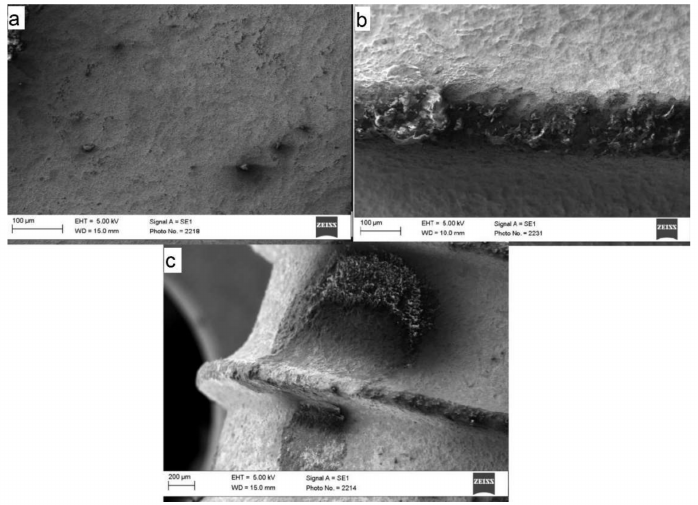
Figure 11. ( a ) The SLA ® shows a slight surface roughness when untreated. Uneven spots can be seen in the valley. ( b ) The SEM images with a laser energy of 160 mJ showed significant changes, especially at the head of the threads. Less noticeable changes were seen in the valley. ( c ) The surface could be significantly altered at the valley in tandem with the increasing energy level at 250 mJ. This resulted in severe structural changes to the surface of the implant.